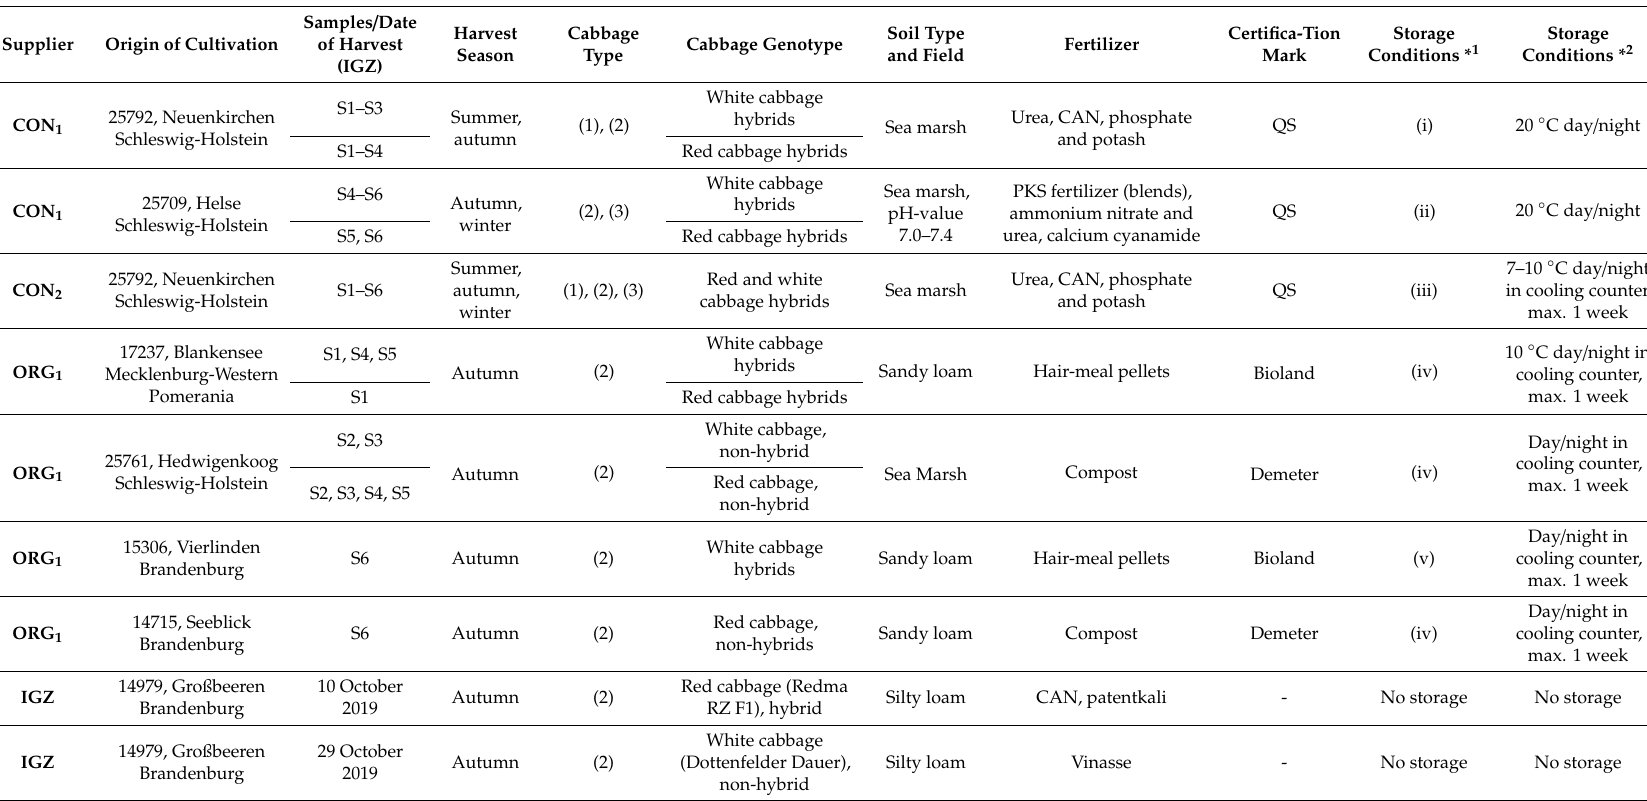
Table 2. Total overview of the German origin, cultivation, and storage conditions of commercial red and white cabbages and red and white cabbages from the field experiment. Purchase dates of S1–S6 can be found in Table